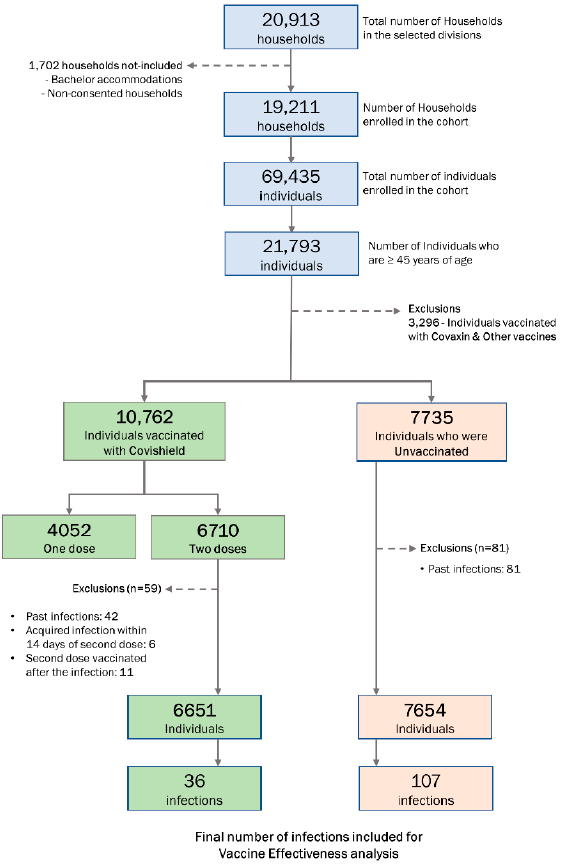
Figure 2. Participant enrollment, events, and data exclusions for estimating the effectiveness of ChAdOx1 nCoV-19 coronavirus vaccine (CovishieldTM) in reducing the delta variant of SARS- CoV2 infection, Chennai, Tamil Nadu, India, 2021 . infection, Chennai, Tamil Nadu, India,